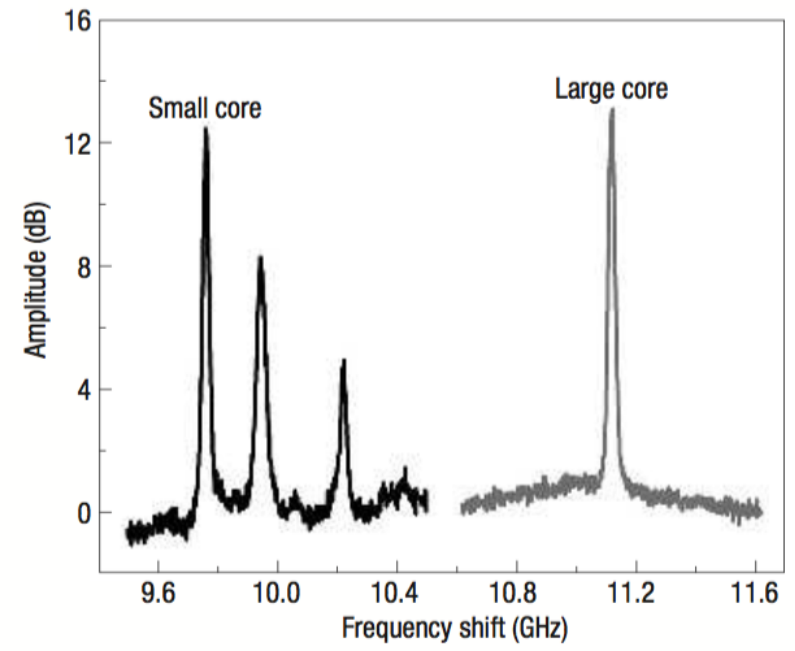
Figure 5. Comparison of the Brillouin spectrum in a large core diameter photonic crystal fibre (PCF) and a small core diameter PCF [102]. Reprinted with permission from Springer Nature: Nature, Nat. Phys., [102], Copyright 2006. BFS, Brillouin frequency